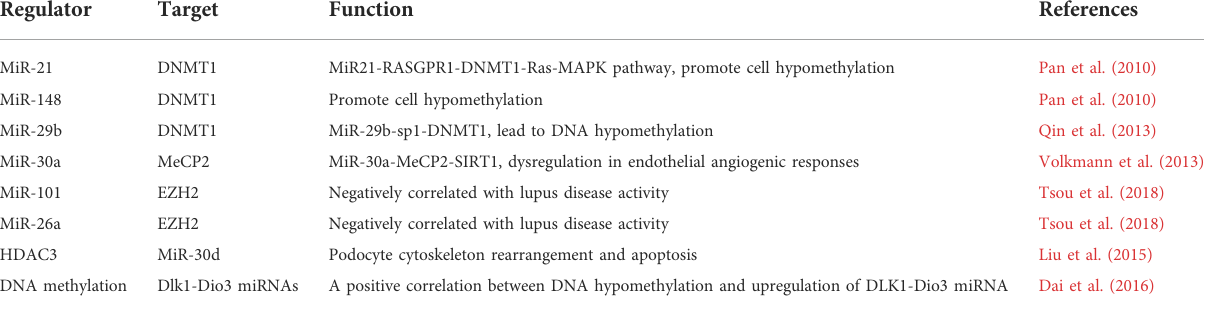
TABLE 3 The Interplay between epigenetics and miRNA.